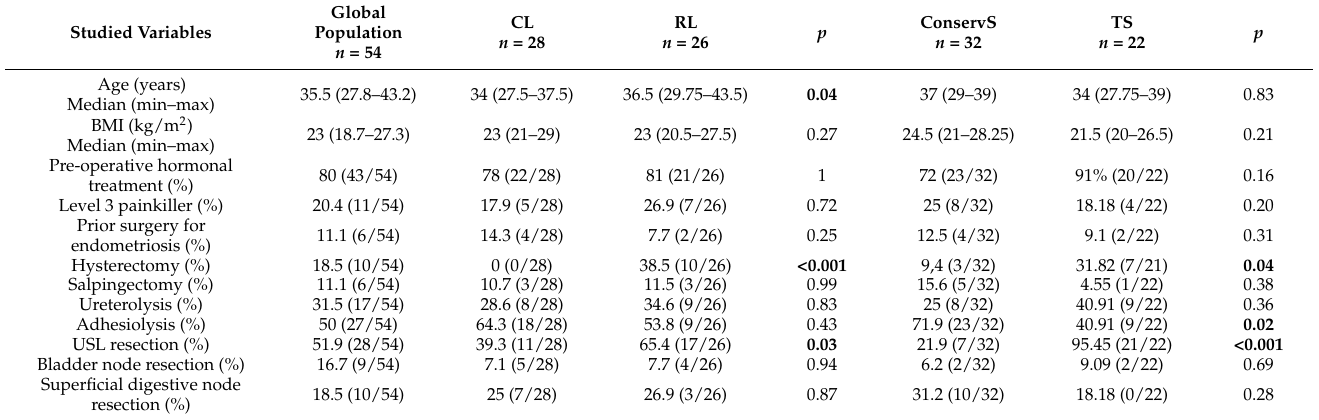
Table 1. Description of global population using median (min–max) and % for age (years), BMI (kg/m 2 ), pre-operative treatment (morphine derivative painkiller, hormonal treatment), prior surgery for endometriosis, and type of resection in the two subgroups: RL vs. CL and ConservS vs.